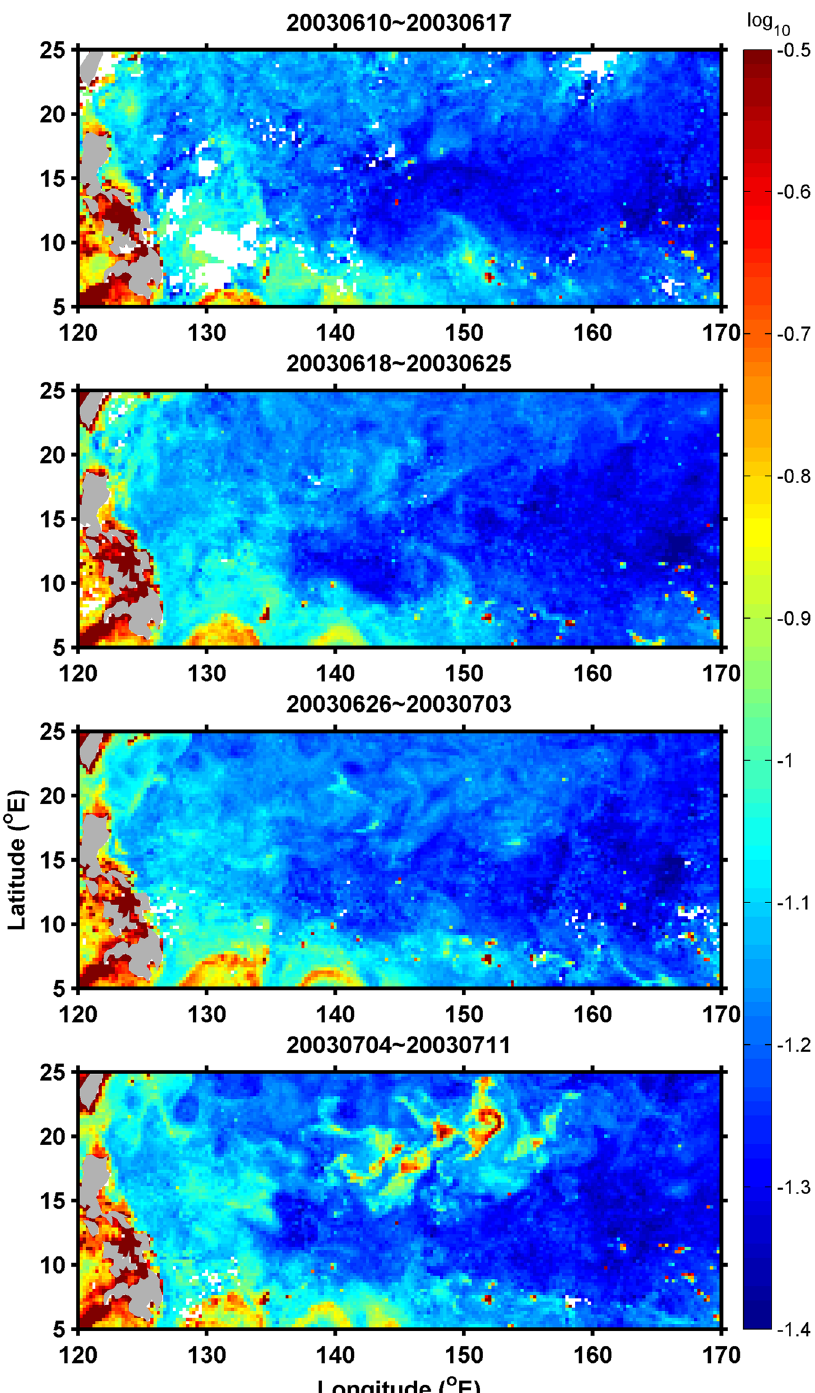
Figure 6. Ocean color images (log 10 of Chl, mg/m 3 ) from June 10 to July 11 in